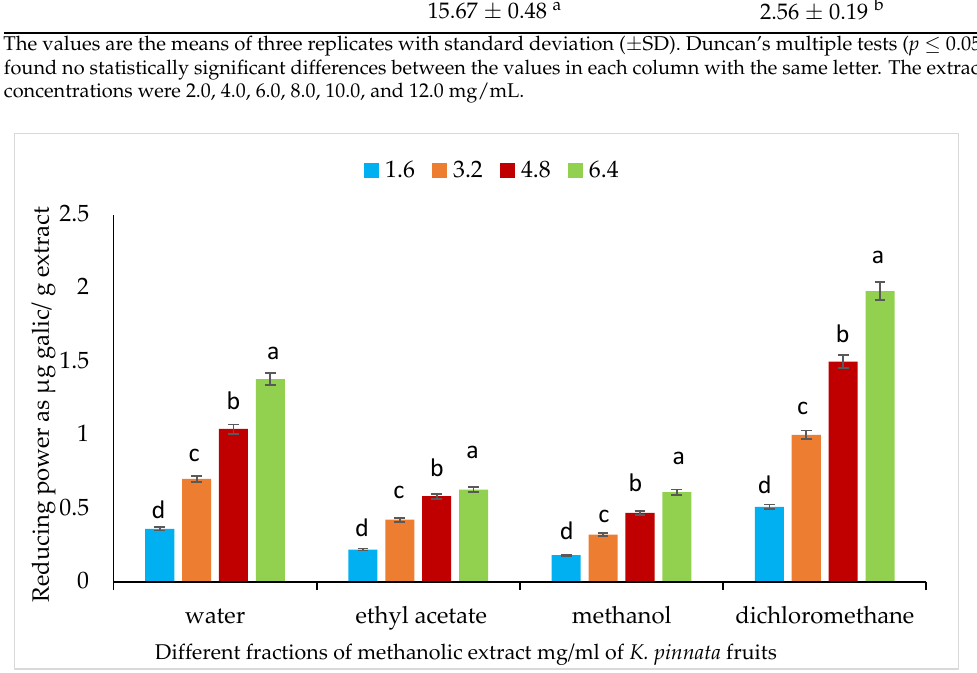
Figure 5. Antioxidant capacity of different fractions (water, ethyl acetate, methanol and dichloro- methane) of mature (K m ) fruits of K. pinnata . The values are the means of three replicates with standard deviation (±SD). Duncan’s multiple tests ( p ≤ 0.05) found no statistically significant dif-